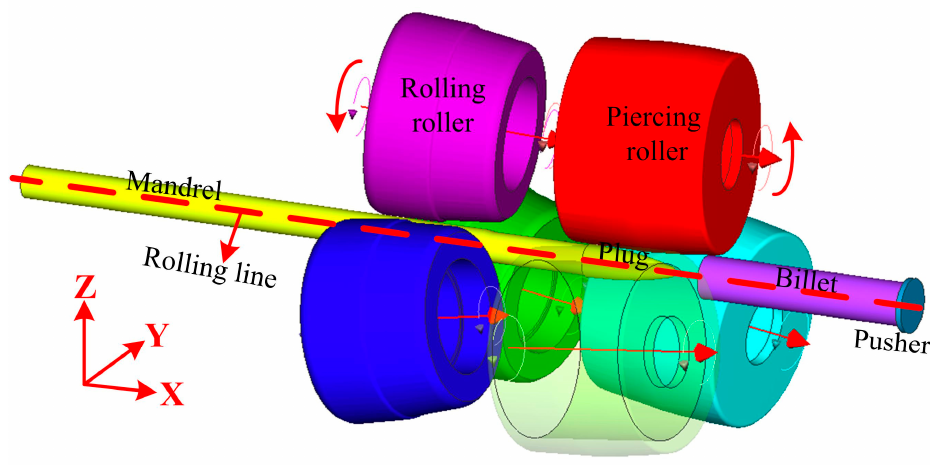
Figure 2. Simulation model of the TSR process. The plug and mandrel are arranged along the X direction in the model. The bar advances along the X -axis during the rolling process. Once the model was imported into the simulation software, all of the tools and dies involved in deformation were set as rigid bodies except for the workpiece. The temperature of all dies was set at 150 ◦ C and the ambient temperature was set to 20 ◦ C. The bar mesh was selected as a hexahedral mesh with a cell size of 1.3 mm and a quantity of approximately 35,000. The friction type was Coulomb friction, the friction coefficient between the bar and roller was 0.8 and the friction coefficient between the bar and plug was 0.5. The element composition of the TC4ELI bar selected in the finite element simulation is shown in Table